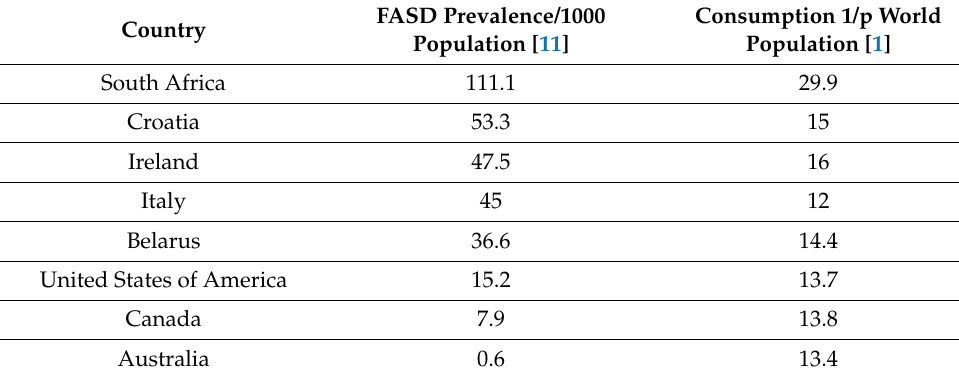
Table 1. Rates of FASD per 1000 population and liters alcohol per person. FASD Prevalence/1000 Consumption 1/p World Country Population [11] Population [1] South Africa 111.1